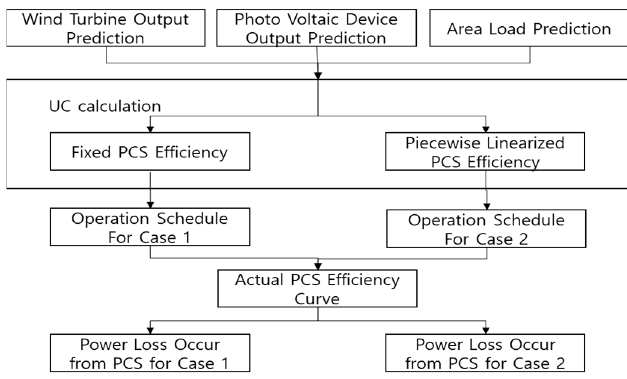
Figure 4. Analysis process for case study.